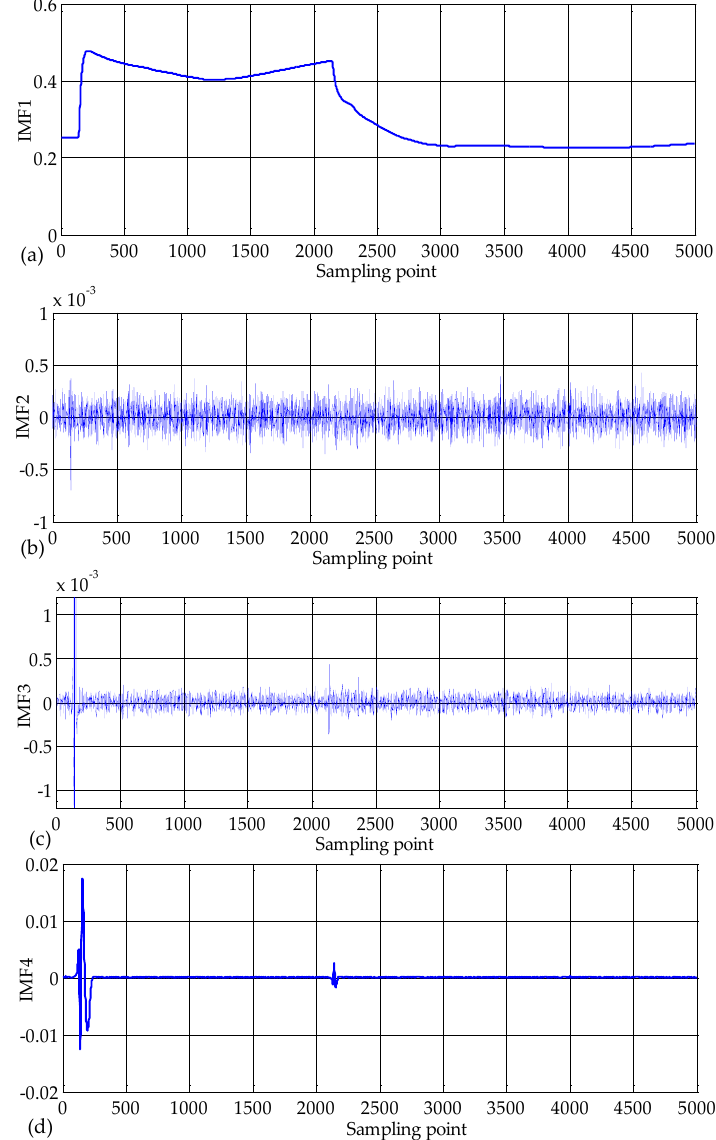
Figure 12. Ensemble empirical mode decomposition (EEMD) results of analytical signal at the terminal M: ( a ), ( b ), ( c ), and ( d ) intrinsic mode function 1, 2, 3, and 4 respectively.